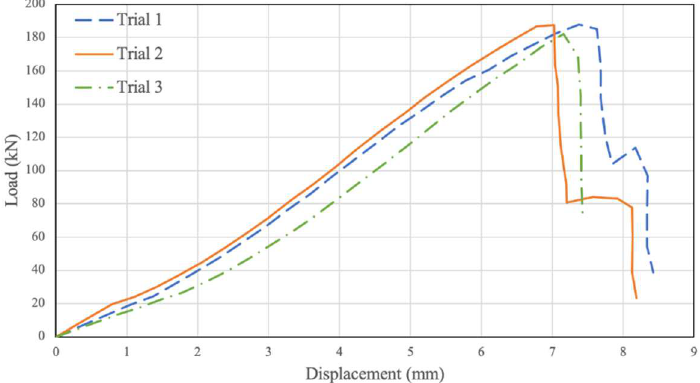
Figure 10. Confined 8.9 Mpa. Displacement vs. Load.